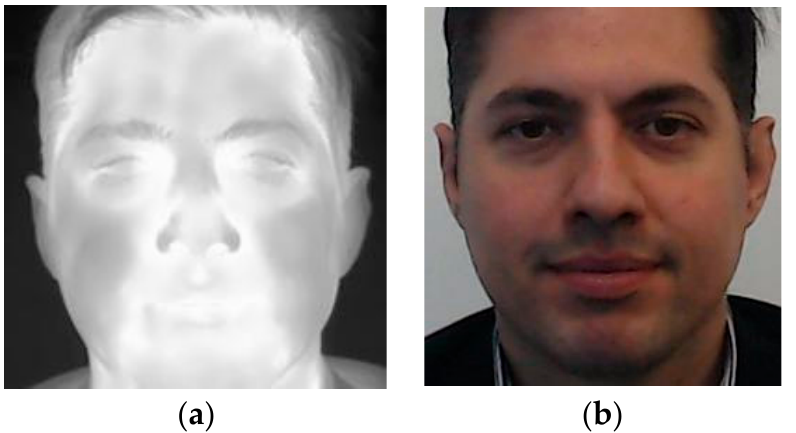
Figure 3. Sample face images from the Speaking Faces dataset: ( a ) thermal infrared; ( b ) visible spec- trum.